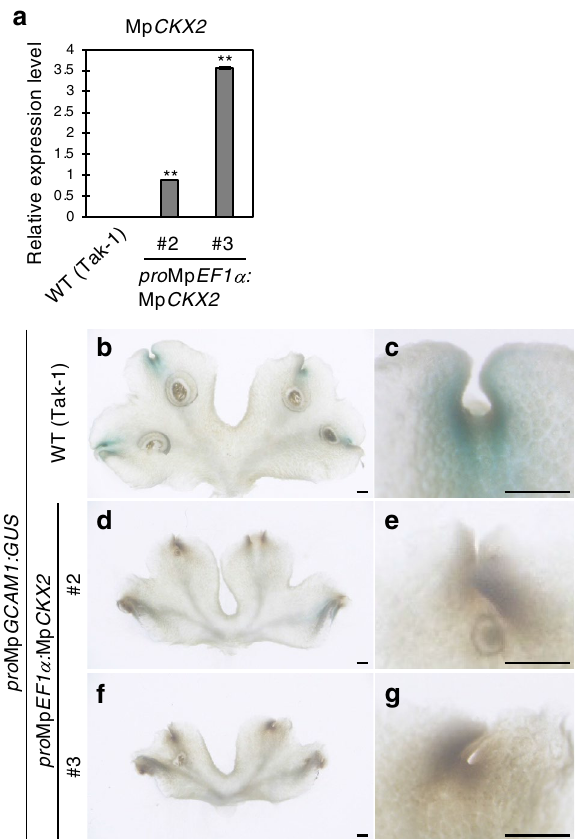
Figure 3. Expression pattern of Mp GCAM1 in the Mp CKX2 -overexpressing line. ( a ) Transcript levels of Mp CKX2 in the wild-type (Tak-1) and Mp CKX2 -overexpressing lines #2 and #3. mRNA levels were normalized to that of Mp EF1α . Data are presented as mean ± SD ( n = 3). Significant differences from the wild-type were determined by the Student’s t-test as follows: ** P < 0.01. ( b–g ) GUS staining of 20-day-old thalli carrying pro Mp GCAM1:GUS . Wild-type (Tak-1) and the Mp CKX2 -overexpressing lines #2 and #3 were observed. Magnified images around the apical notch are shown ( c,e,g ). Bars represent 1